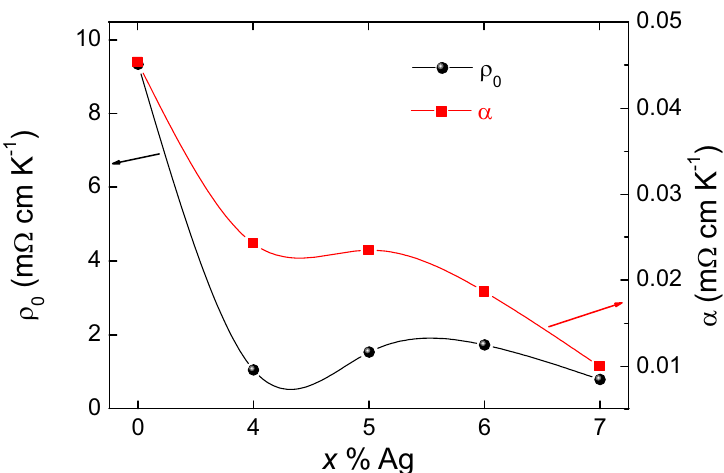
Figure 5. Variation of ρ 0 and α for the Ag-doped samples with 4, 5, 6, and 7 wt.% Ag additions as determined from the resistivity measurements.